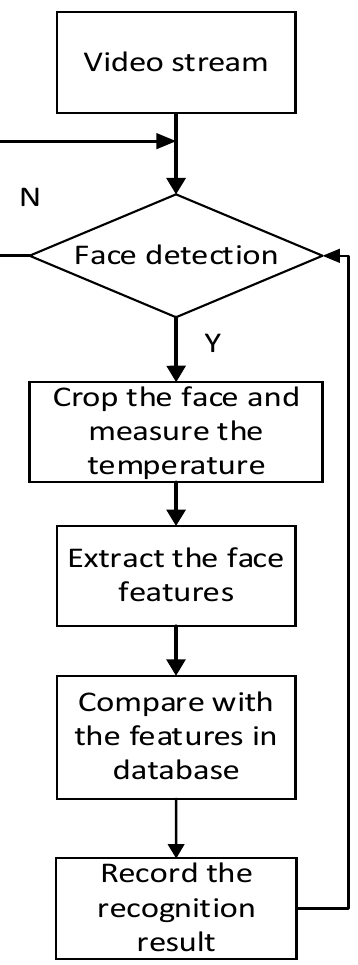
Figure 1. The execution flow of entire system.